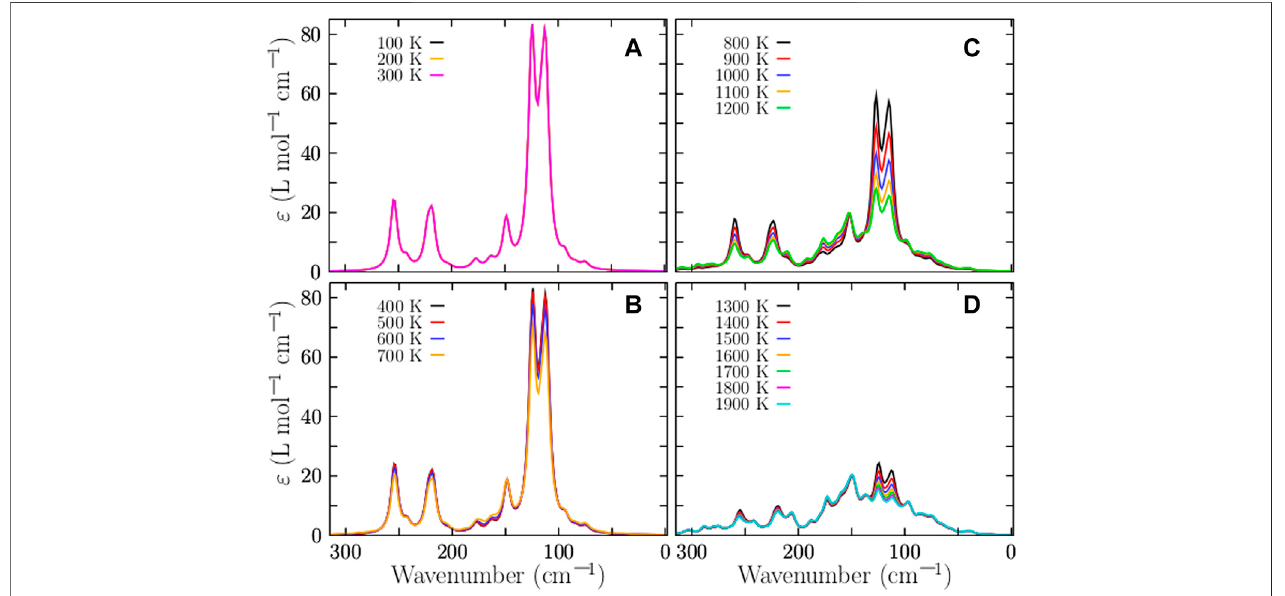
FIGURE 4 | (Color online) Temperature-dependent IR Boltzmann -spectra -weighted at room temperature of the neutral Cu 38 cluster are shown in panels (A) – (D) for various temperatures. The computed IR spectrum of each isomer is multiplied by its corresponding Boltzmann weight at fi nite temperature; Then, they are summed together to produce a fi nal Boltzmann-weighted IR spectrum. Each spectrum of each isomer is computed using density functional theory as implemented in Gaussian codeattheB3PW91-D3/def2-TZVPleveloftheory.ThelargechangeintheIRspectraoccursatatemperatureof824 K,aswecanseeinpanel (D) ,andthisagrees with the relative occurrence displayed in Figure 2B . The bulk melting temperature of copper is 1358 K (Grigoryan and Springborg, 2019), considering this, our result below of this temperature are well-behaved.